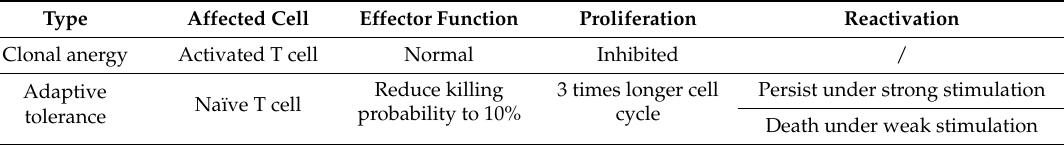
Table 3. Properties of anergic T cell [51,52].